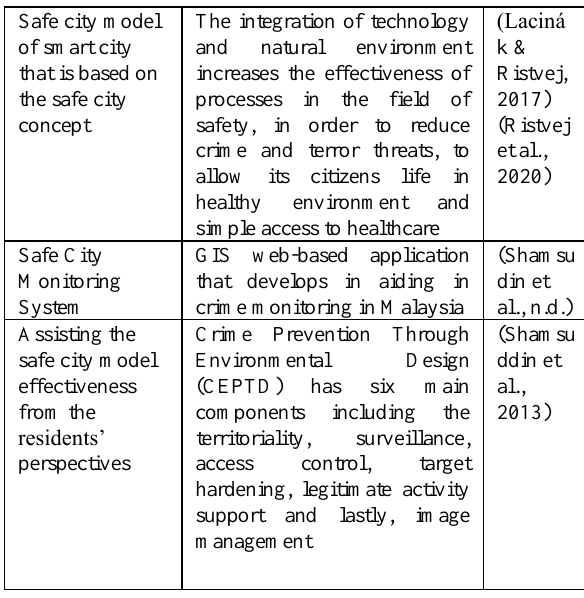
Table 2. Previous studies on the safe city